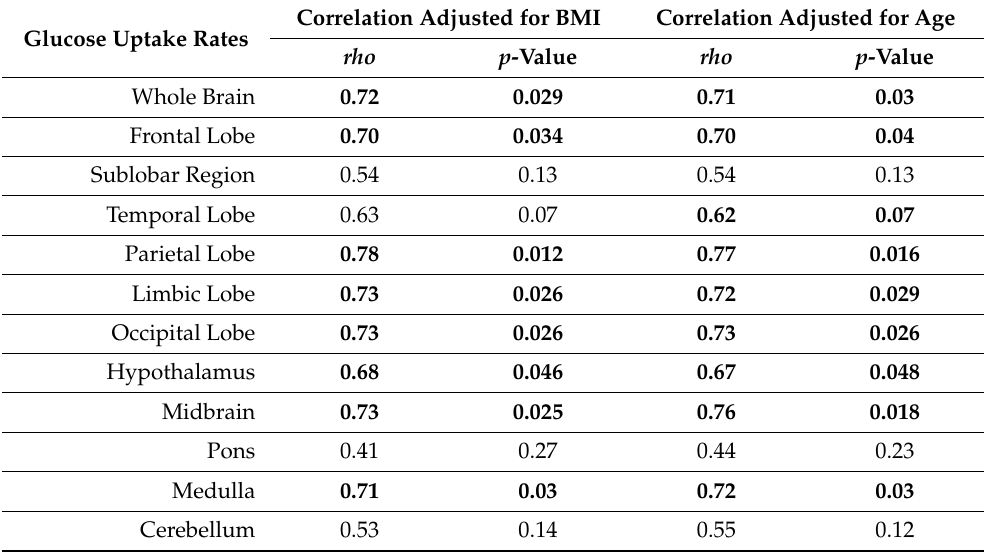
Table 2. Partial Correlations Analysis BAT UCP-1 expression and Cold-Stimulated Brain Glucose Uptake Rate. Correlation Adjusted for BMI Correlation Adjusted for Age Glucose Uptake Rates rho p -Value rho p